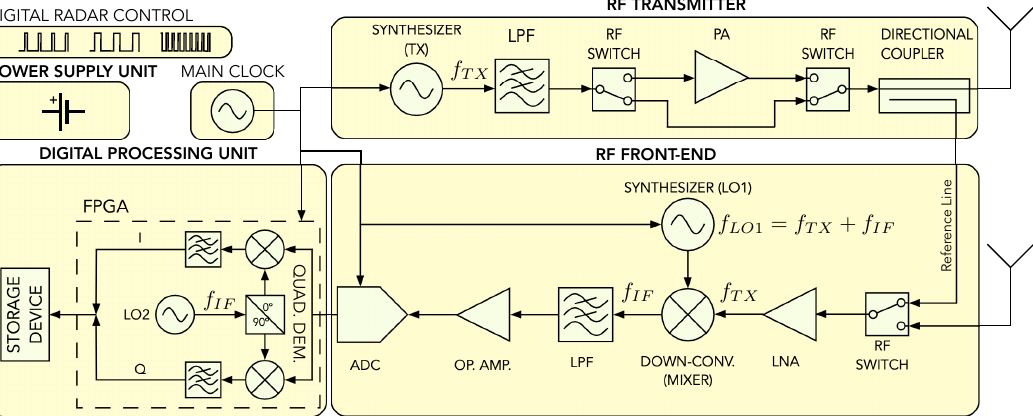
Figure 1. Block scheme of super-heterodyne Stepped Frequency Continuous Wave (SFCW) radar [15].